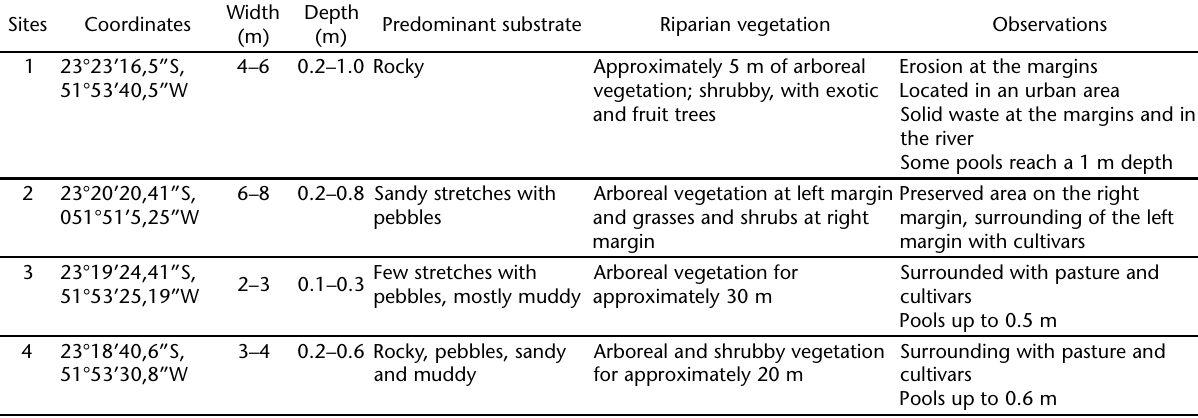
Table I. Physical characteristics of the sampling sites sampled in the the Morangueiro (sites 1 and 2) and Queçaba (sites 3 and 4) streams, Pirapó River Basin, Maringá, Paraná State.